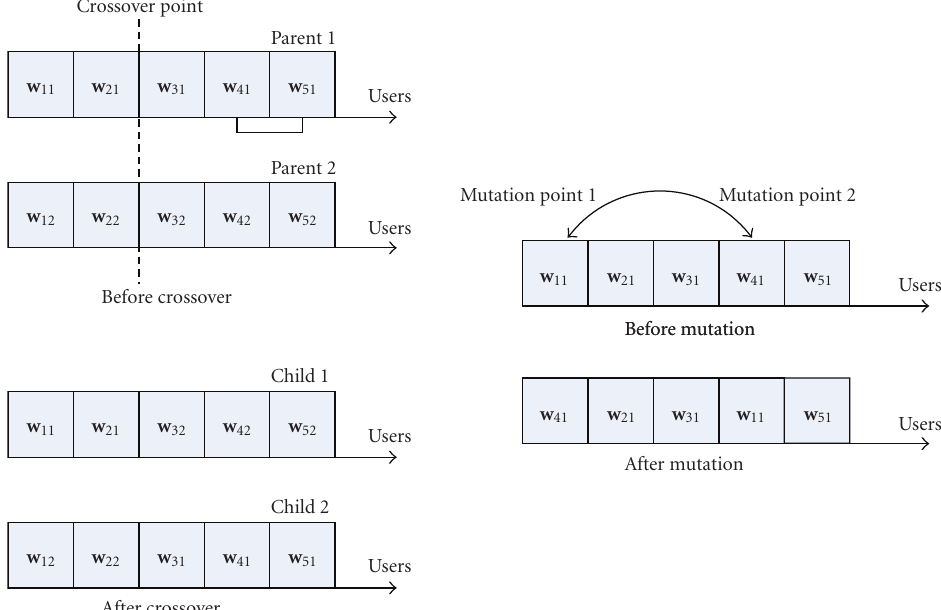
Figure 14: Crossover and mutation operations in genetic